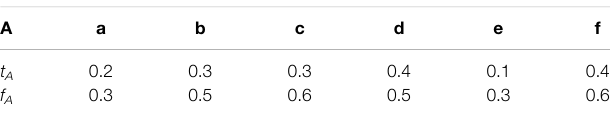
TABLE 2 | Vague set A on set V.